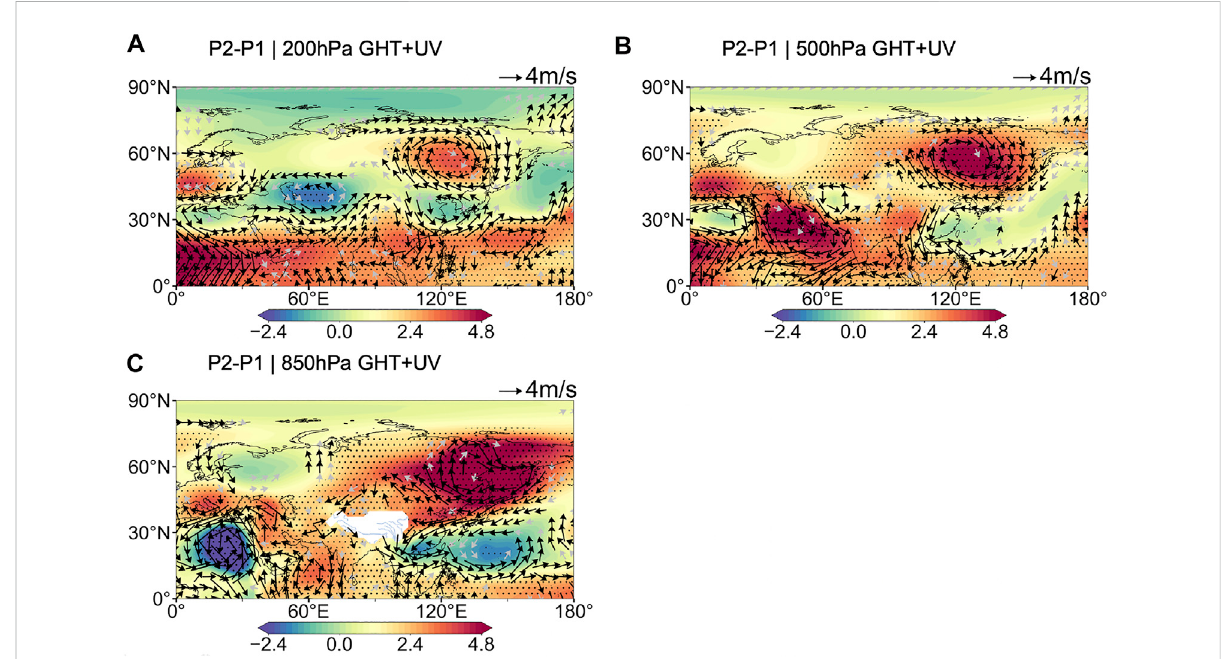
FIGURE 12 Composite differences (P2 minus P1) of atmospheric circulation between 1951 and 1980 (P1) and 1981 – 2010 (P2). Black dots marks regions where geopotential height (GHT) differences are above the 90% con fi dence level. The black vectors show the wind differences are over 90% con fi dence level. The wind and GHT data at 850 hPa on the Qinghai-Tibet Plateau are ignored. (A) P2-P1 | 200 hPa GHT+UV. (B) P2-P1 | 500 hPa GHT+UV. (C) P2-P1 | 850 hPa GHT+UV.